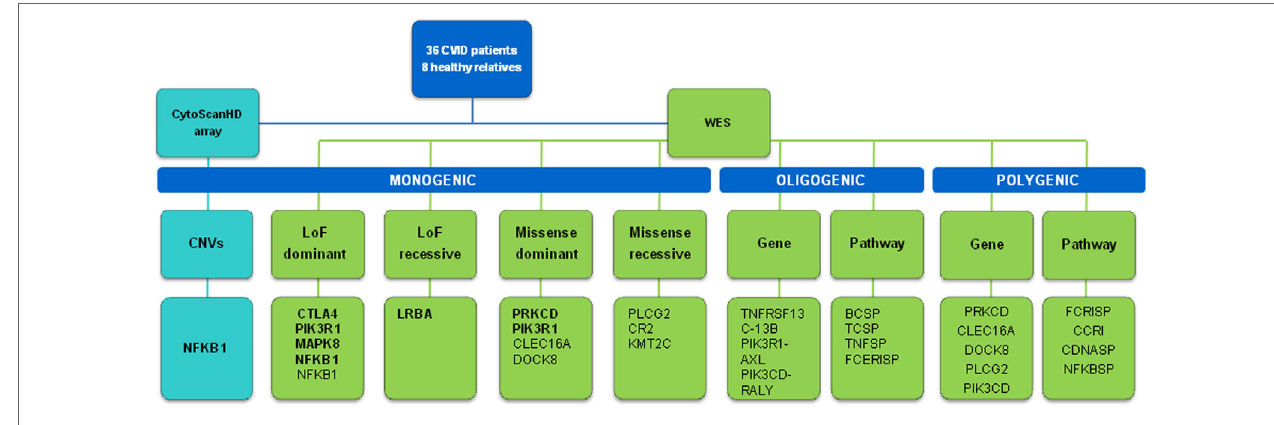
FigUre 4 | Scheme of the approaches and main results of this study. Candidate genes in bold are those with more evidences of being